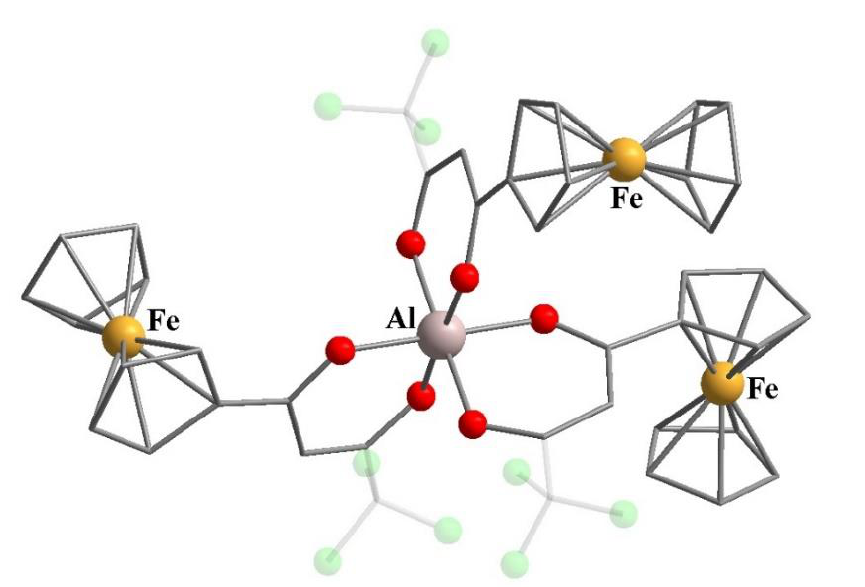
Figure 29. Molecular structure of 55 [98]. Hydrogen atoms have been omitted, CF 3 groups are transparent for clarity. The cif has been retrieved from CCDC. CCDC number is 877638. The heterometallic [Cu-Fe] complex 56 was isolated in a good yield (45%) from the reaction of HL 16 with [CuCl(PPh 3 )] in the presence of potassium tert -butylate in ether at room temperature (Scheme 23) [99]. Complex 56 showed the irreversible oxidation of Cu(I) centers to Cu(II) under anaerobic electrochemical conditions accompanied by the loss of PPh 3 coligands and the formation of bis -diketonate [Cu( L 16 ) 2 ].